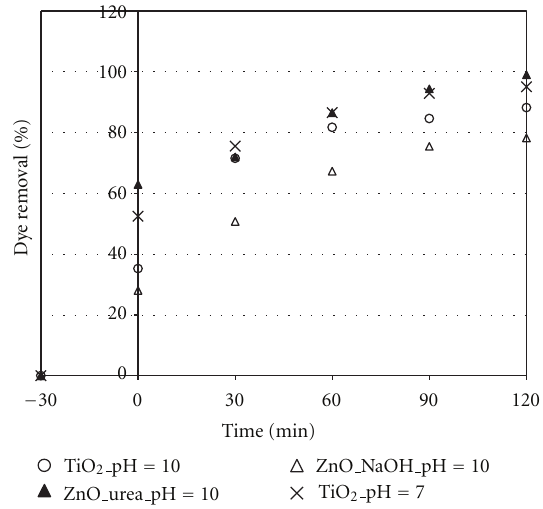
Figure 11: Comparison between R 6G removal on ZnO and TiO 2